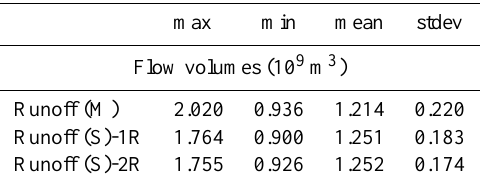
Fig. 4. Comparison of simulated to measured streamflow processes at validation stage, the simulation started in 1961 (ROF=runoff; Fig. 4 Comparison of simulated to measured streamflow processes at validation stage, the simulation started in 1961 (ROF, runoff; m, measured; 2 m=measured; 1R,=one-reservoir method; 2R=two-reservoir method). 1R, one-reservoir method; 2R, two-reservoir method) 3 Table 2. The NSE and PBIAS for the simulated discharge by SWAT Table 3. Statistical analysis for the baseflow components and index using the one-reservoir and two-reservoir baseflow approaches in for Manas River basin, Tianshan, northwest the Manas River basin, Tianshan, China.